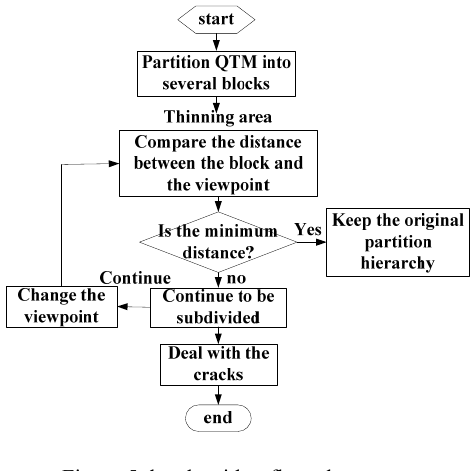
Figure 5 the algorithm flow